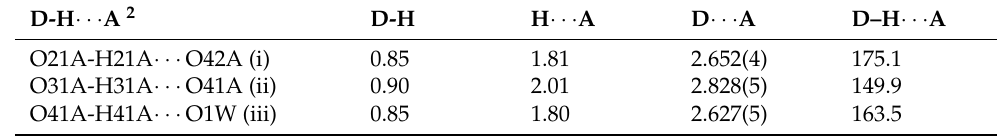
Table 3. Hydrogen bonding interactions (Å, ◦ ) of interconnected 2D layers 1 .